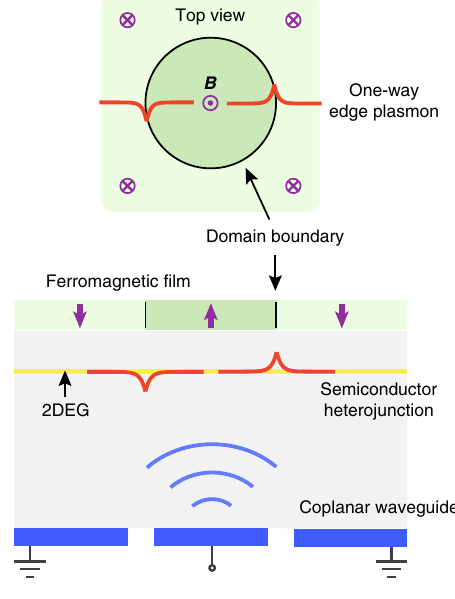
Figure 6 | Schematics of a proposed experimental design based on the 2DEG in a semiconductor heterojunction. Microwave transmitted on the coplanar waveguide can excite one-way edge plasmons at the boundary of opposite magnetic domains. Characteristic resonant absorption can be